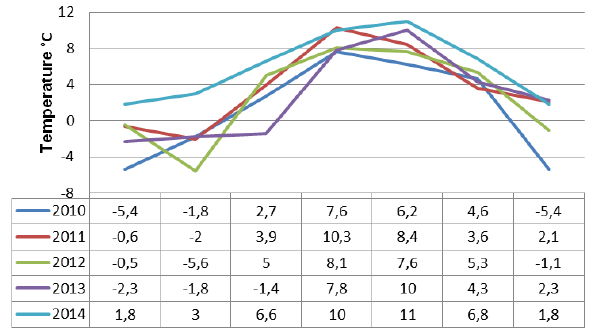
Fig. 3. Monthly temperature data